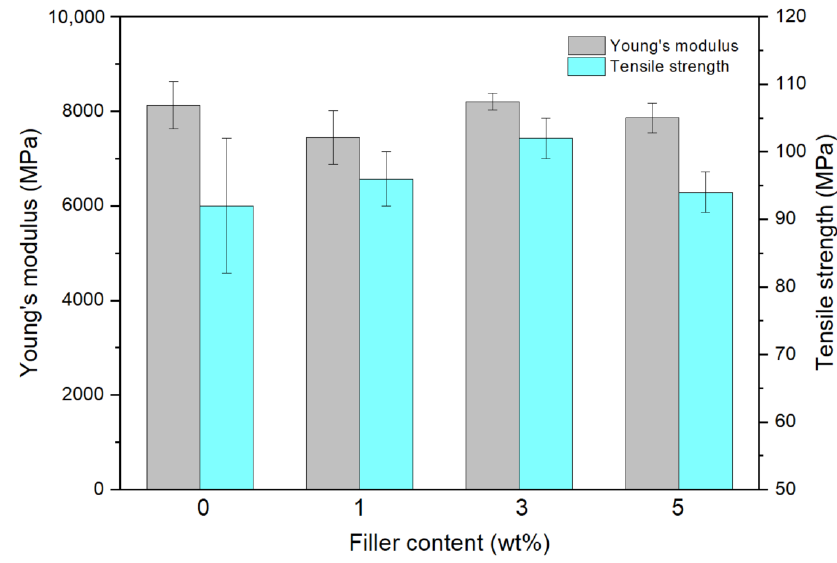
Figure 7. Effect of NP content on the tensile properties of the samples.